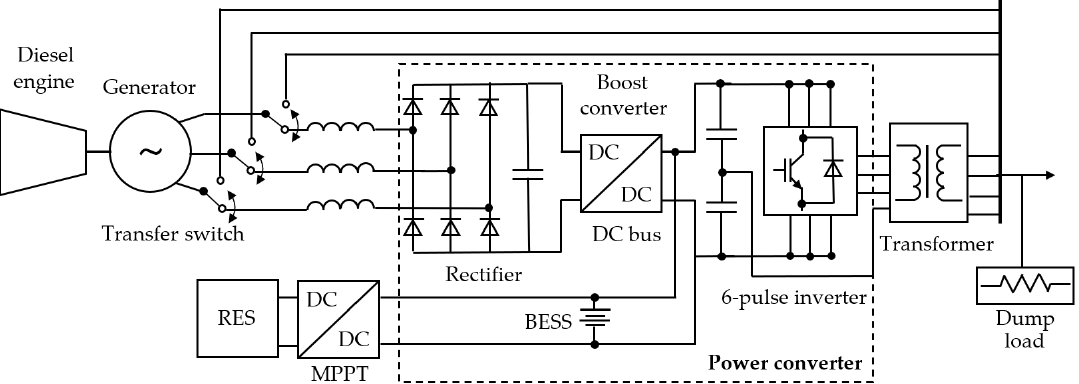
Figure 8. Modified hybrid DG as part of the solar diesel hybrid system. Adapted from Ref. [14].